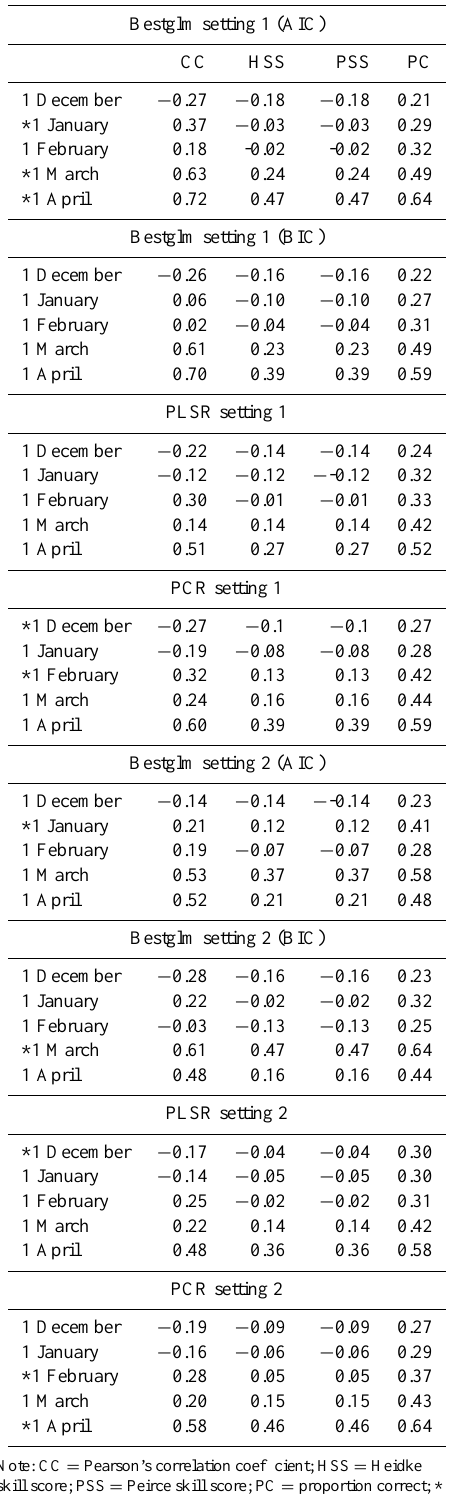
Table 6. Cross-validated prediction performance corresponding to different